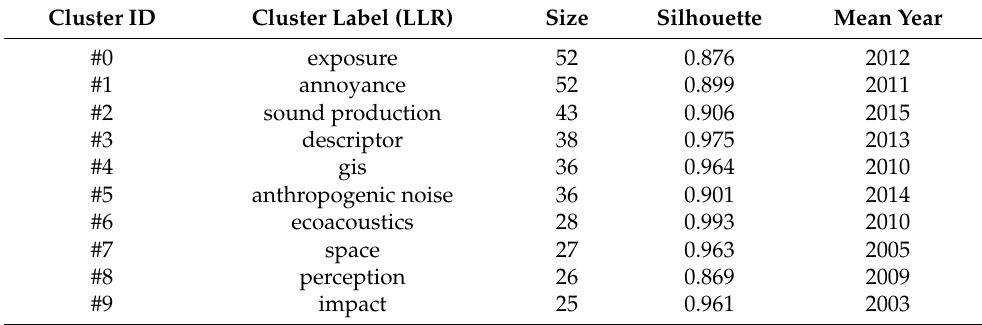
Table 5. The ten largest clusters sorted by